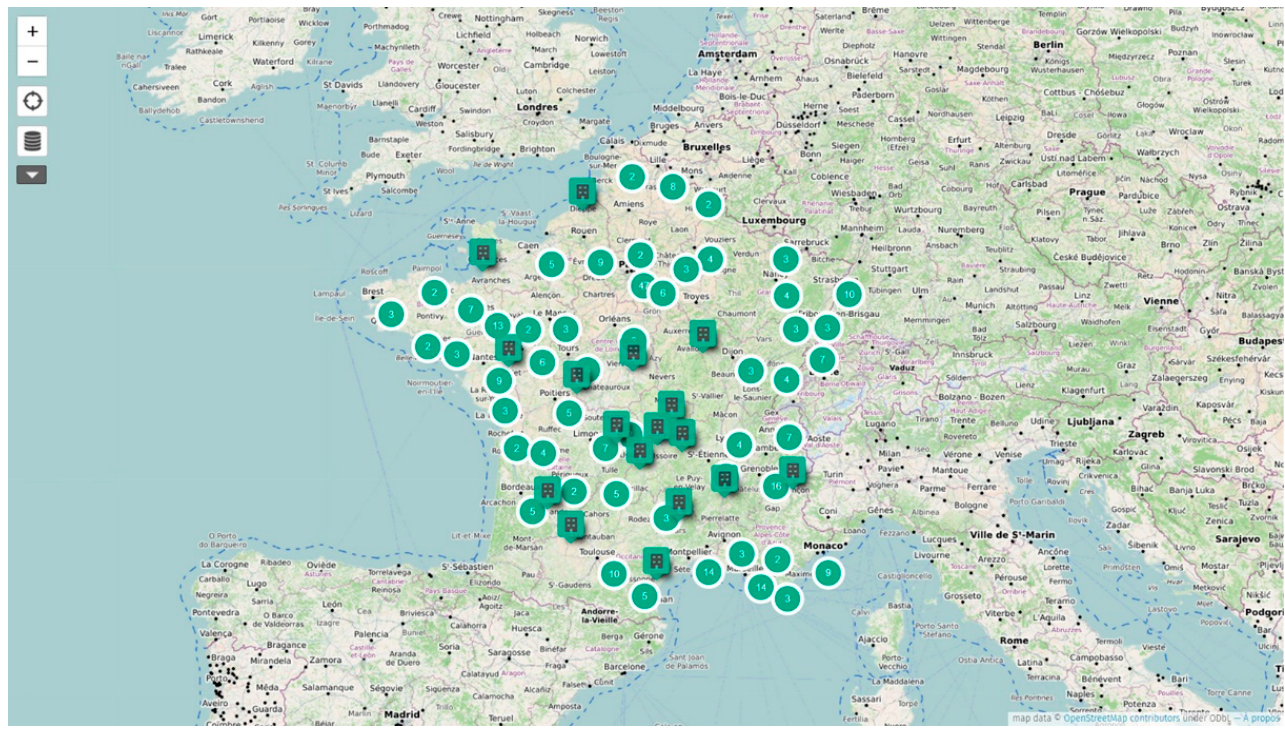
Figure 2. Localization of the ÉcoQuartiers in France with number of ongoing projects per city. Source: http://www.ecoquartiers.logement.gouv.fr/carte-interactive/?vue=map (accessed on 19 June 2022). Table 5. The number of EcoQuartiers through the different stages of the labelling (May 2022). Source: Table 6. The number of EcoQuartiers through the different stages per year from 2013 to 2021 (May 2022). Source: http://www.ecoquartiers.logement.gouv.fr/20-engagements/chiffres-cles/ (accessed on 19 June 2022). Stages of the